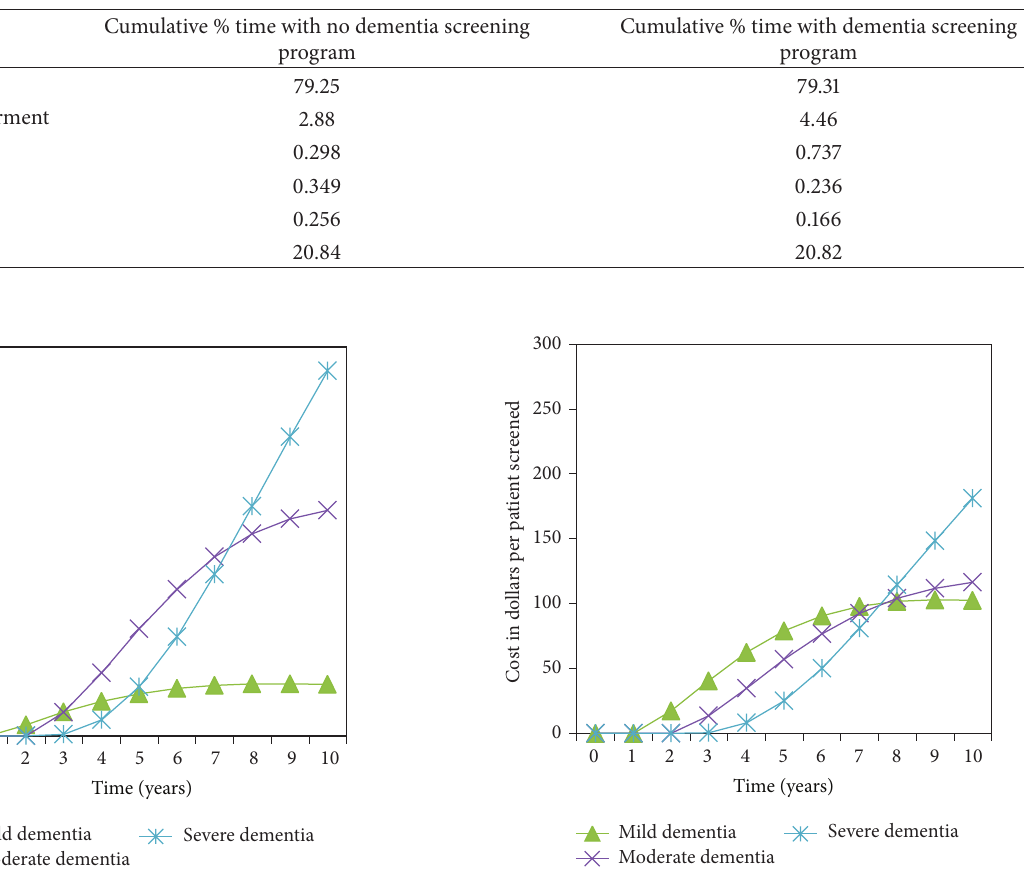
Figure 2: Dementia care cost versus time with dementia